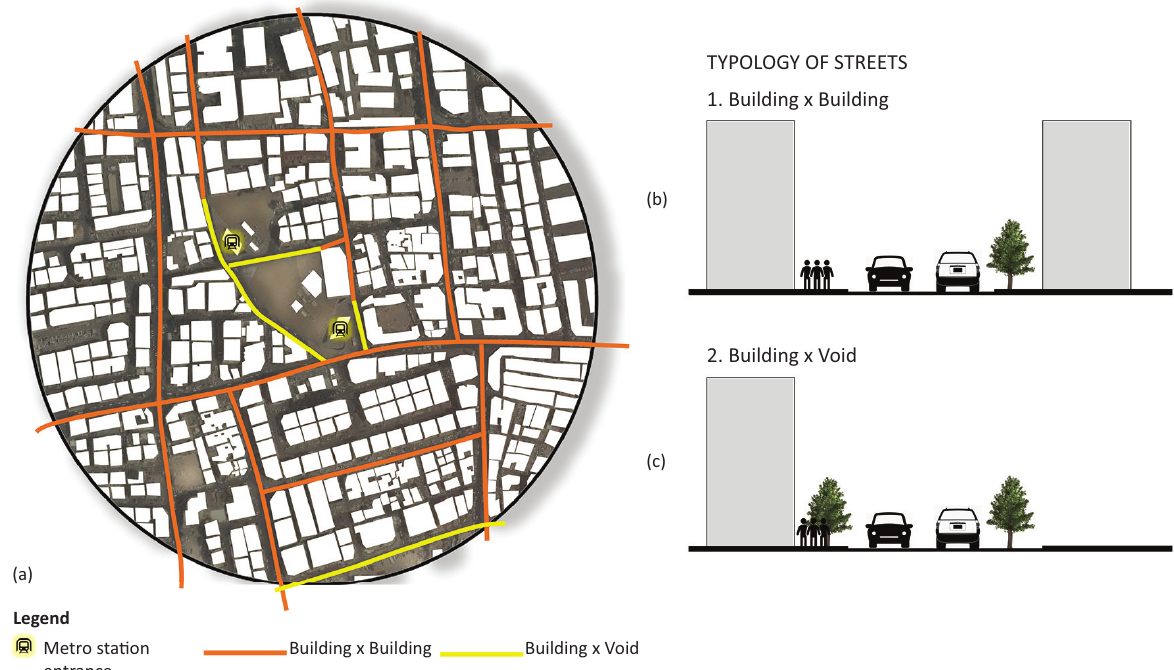
Figure 6. Typology of streets: (a) Main street typology types in the 400 m around Al Mansoura station, (b) building x build‐ ing cross‐section illustration, and (c) building x void cross‐section